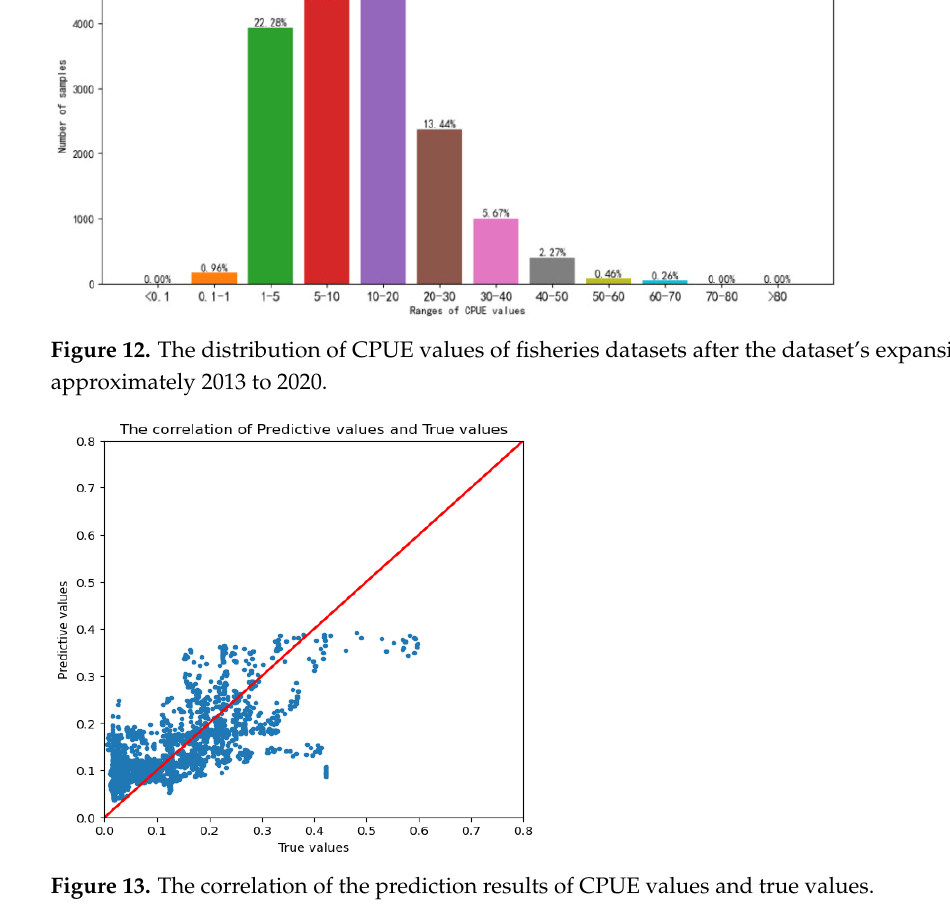
Figure 13. The correlation of the prediction results of CPUE values and true values.